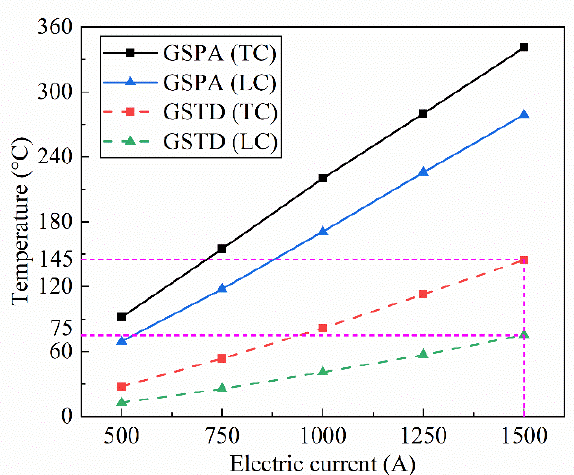
Figure 7. Effect of current intensity on temperature distribution.